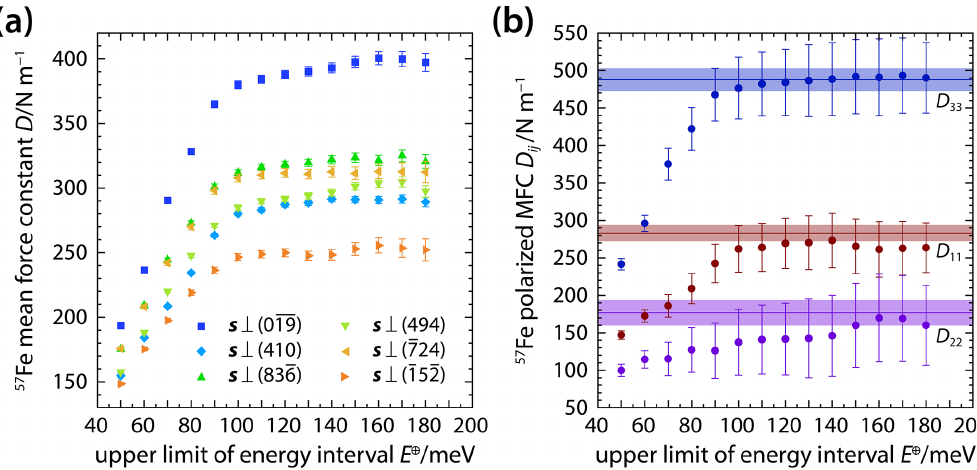
Figure 6. Mean force constants for 57 Fe atoms in δ -(Al,Fe)OOH single crystals. Mean force constants (a) were derived from NRIXS spectra recorded with the X-ray beam incident along different directions s and by stepwise increasing the analyzed energy interval. The anisotropy of the mean force constant (MFC) can be described using a second-rank tensor with the components D 11 , D 22 , and D 33 (b) that can be obtained by inverting (solid circles) the observed mean force constants (shown in a ) or by integrating (horizontal lines) the components of the polarized PDOS (Fig. 2b). Shaded areas indicate uncertainties.